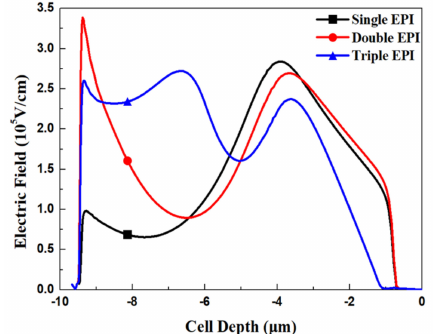
Figure 6. The simulated electric fields for the split-gate trench power MOSFET with ( a ) single EPI, ( b ) double EPIs, and ( c ) triple EPIs at the same EPI thickness. The color bars are scaled on the same degree.